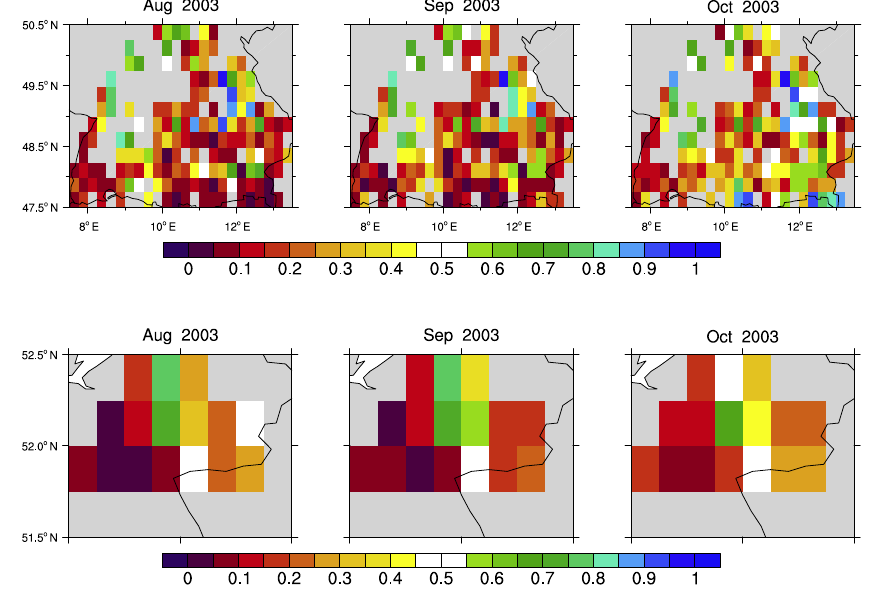
Figure 5. The groundwater drought (SGI) during the months of August, September, and October for the 2003 drought event over the south Germany and east Netherlands study domains, derived from borehole observations and recalculated to 0.25 ◦ grid cells for